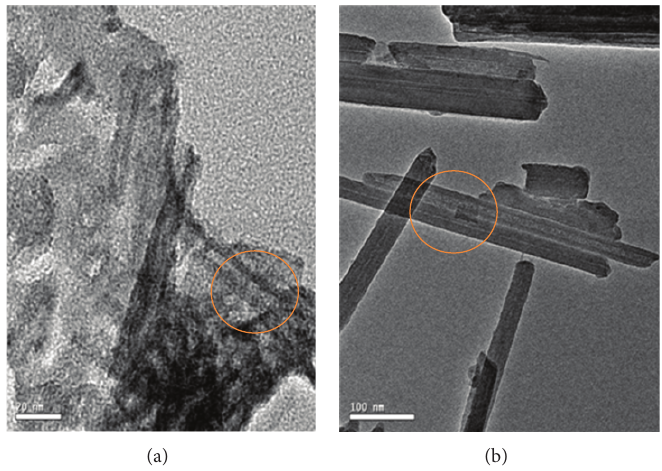
Figure 4: TEM images of (a) TNT and (b) 2.24% Fe TNT.